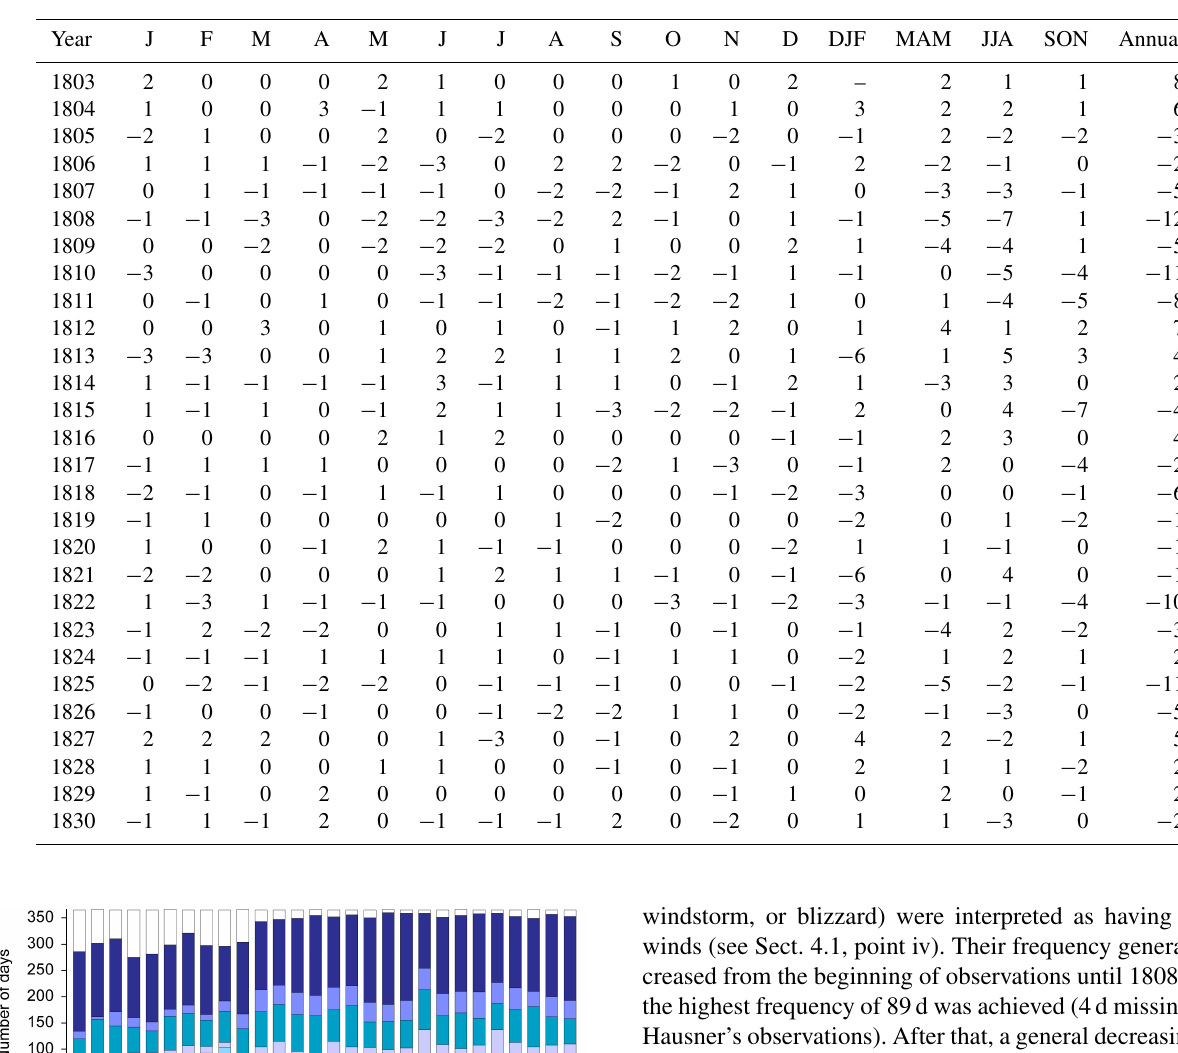
Table 2. Weighted 7-degree precipitation indices reconstructed from daily weather records kept by Šimon Hausner in Buchlovice, 1803– 1830.